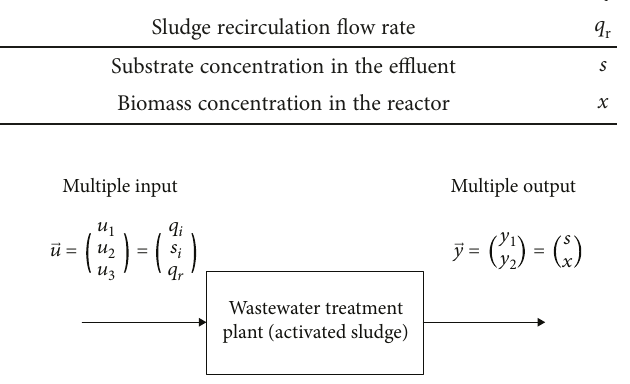
Figure 3: The MIMO system to identify (3 inputs and 2 outputs).